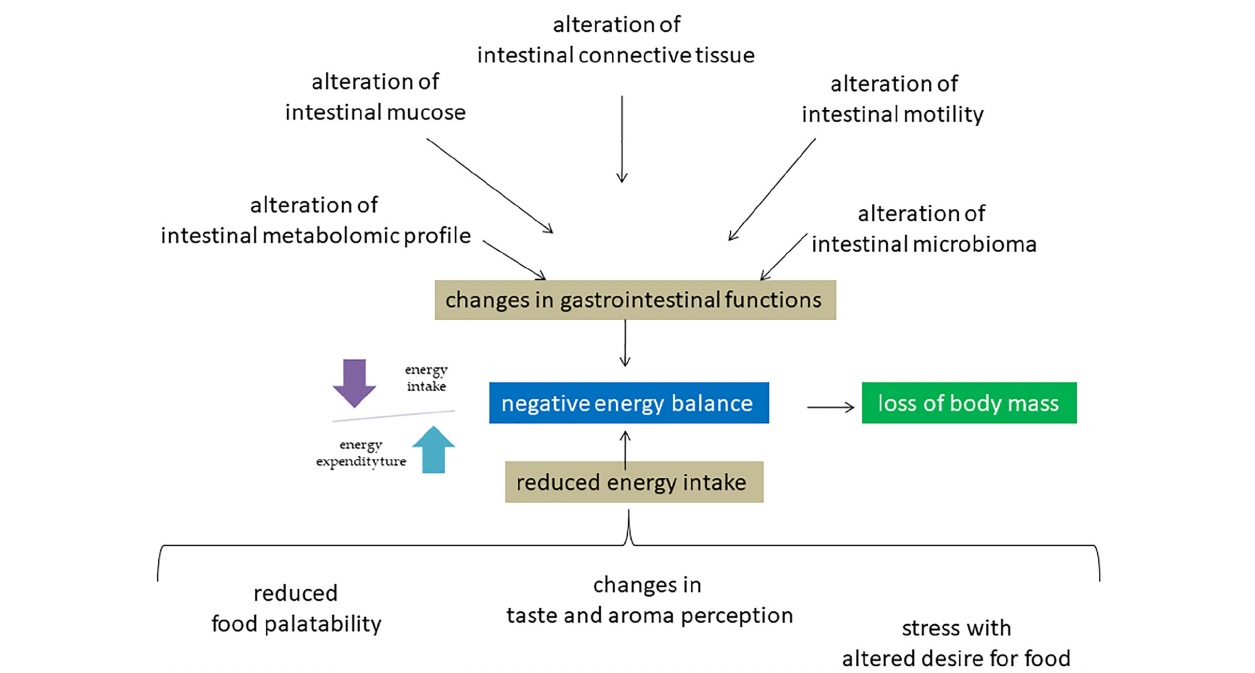
FIGURE 1 | Molecular mechanisms of negative energy balance of astronauts in space environment. Microgravity induces a redistribution of body fluids with consequences on different molecular mechanisms in including intestinal system, sense organs and nerve center of hunger. The consequent negative energy balance is responsible for the disorders of different systems including muscle and bone leading to loss of body